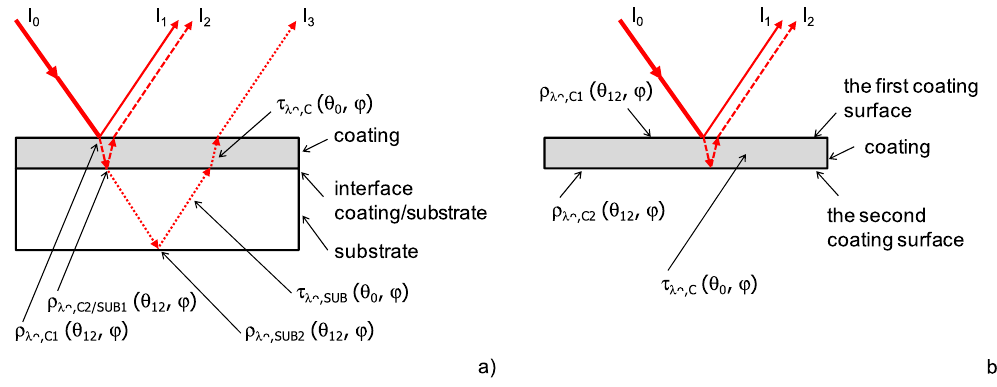
Figure 6. Schematic view of single-reflectance in sample. ( a ) Semitransparent coating deposited on transparent substrate. ( b ) Semitransparent coating without